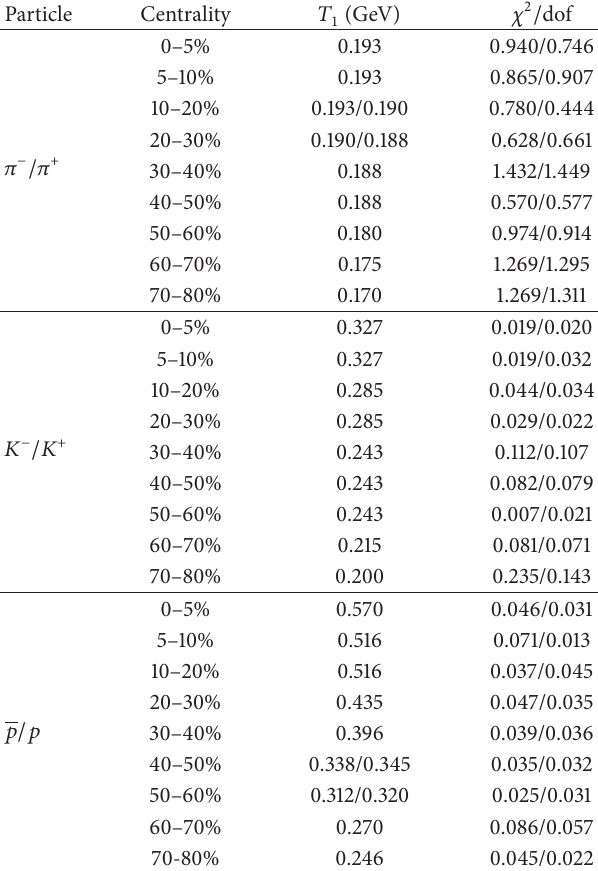
Table 7: Parameter values corresponding to the curves in Figure 7(a)/Figure 7(b). The collisions are Au + Au at